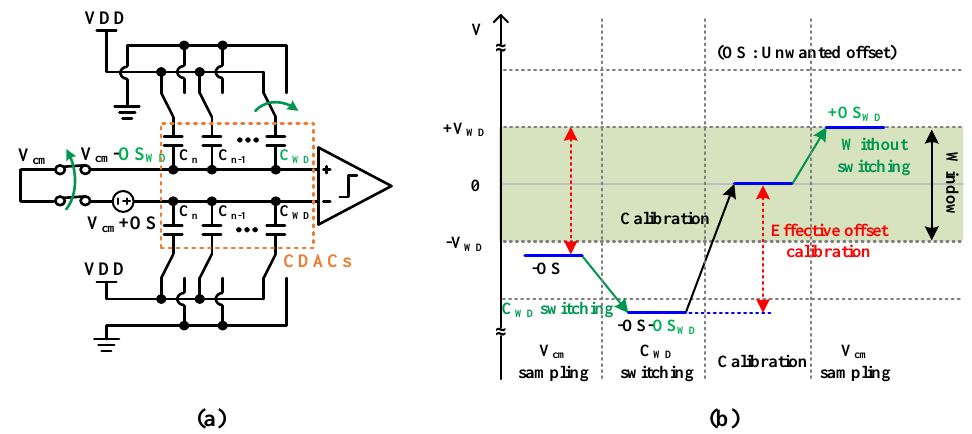
ff set calibration after C Figure 12. The offset calibration after C WD switching to force desired offset. Figure 12. The o